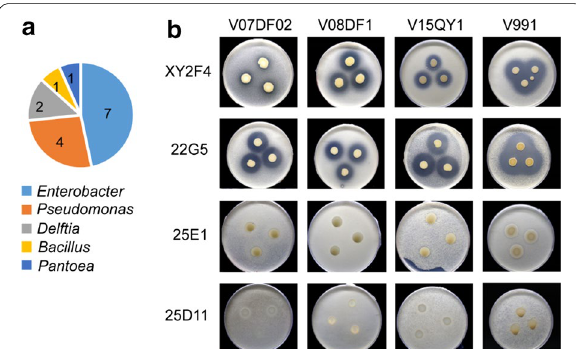
Fig. 1 High-throughput screening of isolates with inhibitory action against V. dahliae . a Species distribution of isolates with inhibitory action against V. dahliae . Species were designated according to similarity to 16S rDNA. b Zone of inhibition assay of strains XY2F4 and 22G5 co-inoculated with conidia of various V. dahliae